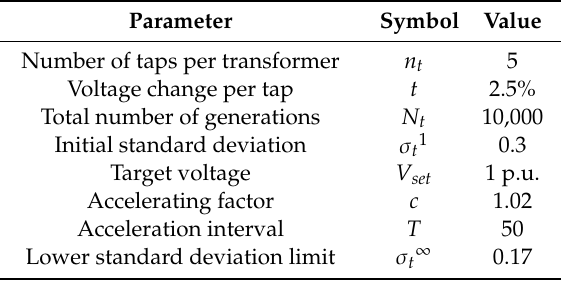
Table 1. Evolution strategy parameters for Case 1.1.